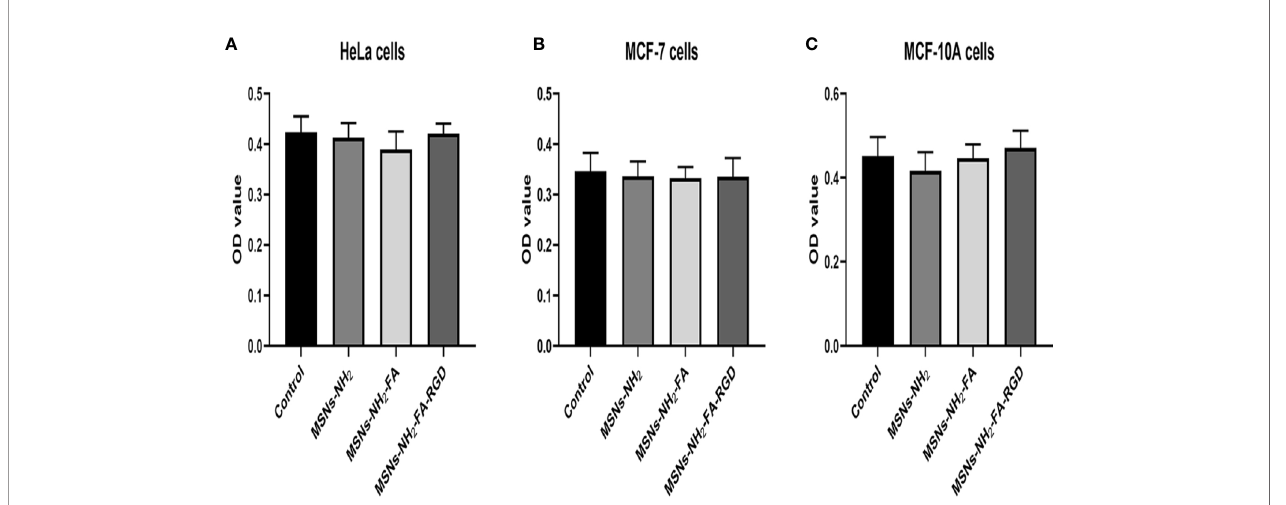
FIGURE 6 | Cell viability of HeLa (A) , MCF-7 (B) and MCF-10A (C) cells after 24 h incubation with MSNs-NH 2 , MSNs-NH 2 -FA and MSNs- NH 2 -FA-RGD at 20 µg·ml -1 .